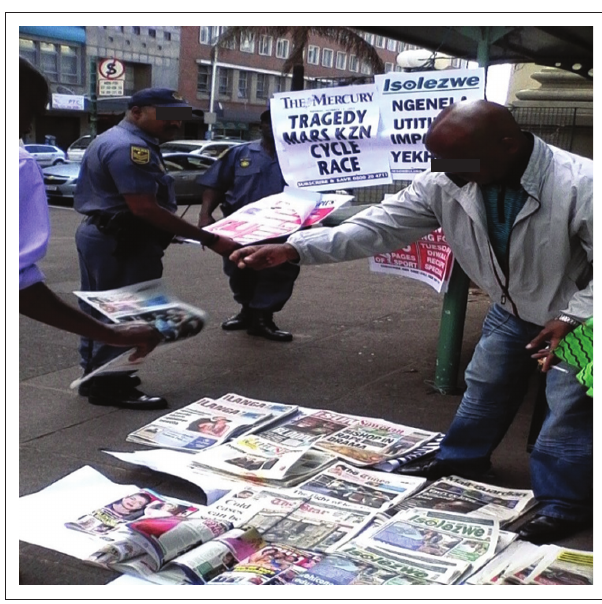
FIGURE 2: Working environment.